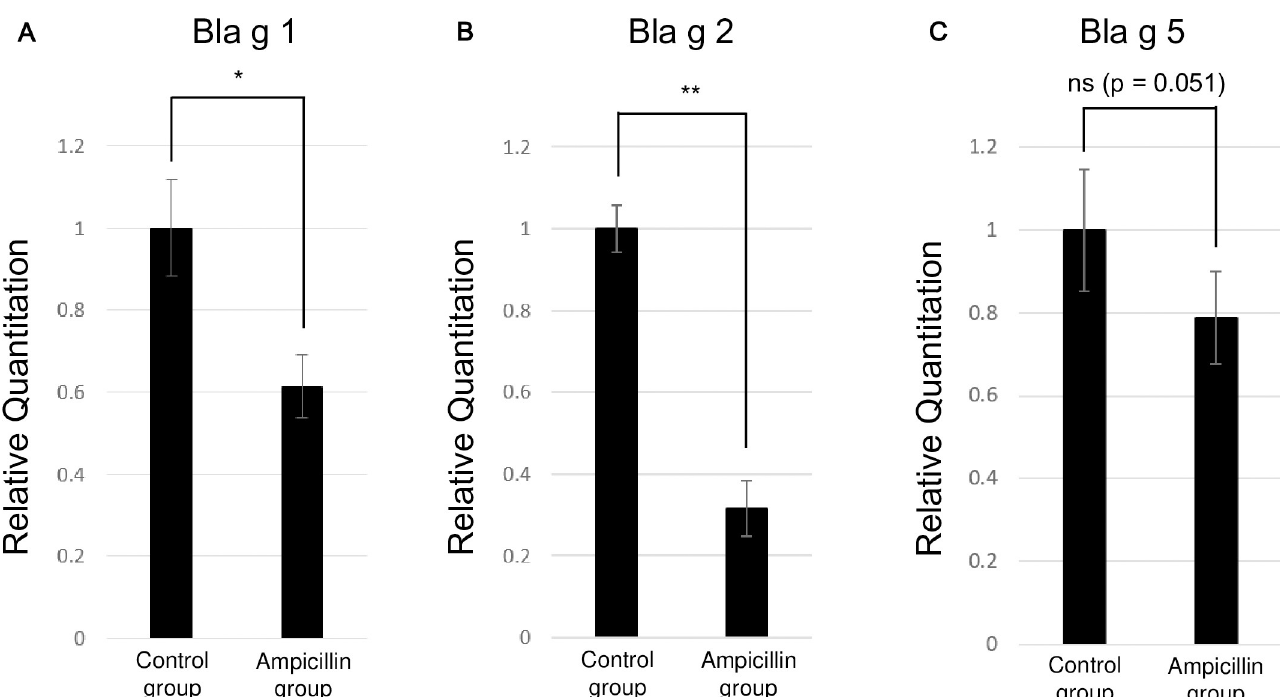
Fig 7. Quantitative PCR (qPCR) analysis showing gene expression levels in cockroaches. (A) Bla g 1 , (B) Bla g 2 , and (C) Bla g 5 .